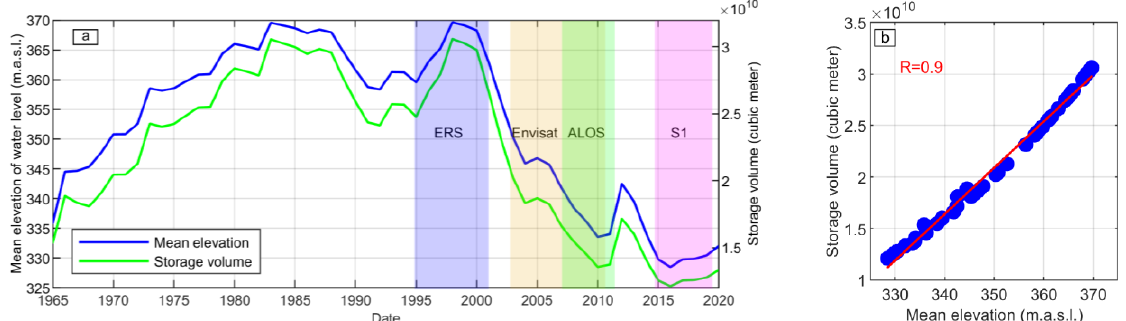
Figure 2. Water level and storage volume in Lake Mead. ( a ) Mean water level in Lake Mead and storage volume (United States Bureau of Reclamation) along with the periods of availability of the four types of SAR data. ( b ) The scatter plot shows the linear correlation between the water level and water storage, along with the correlation coefficient.